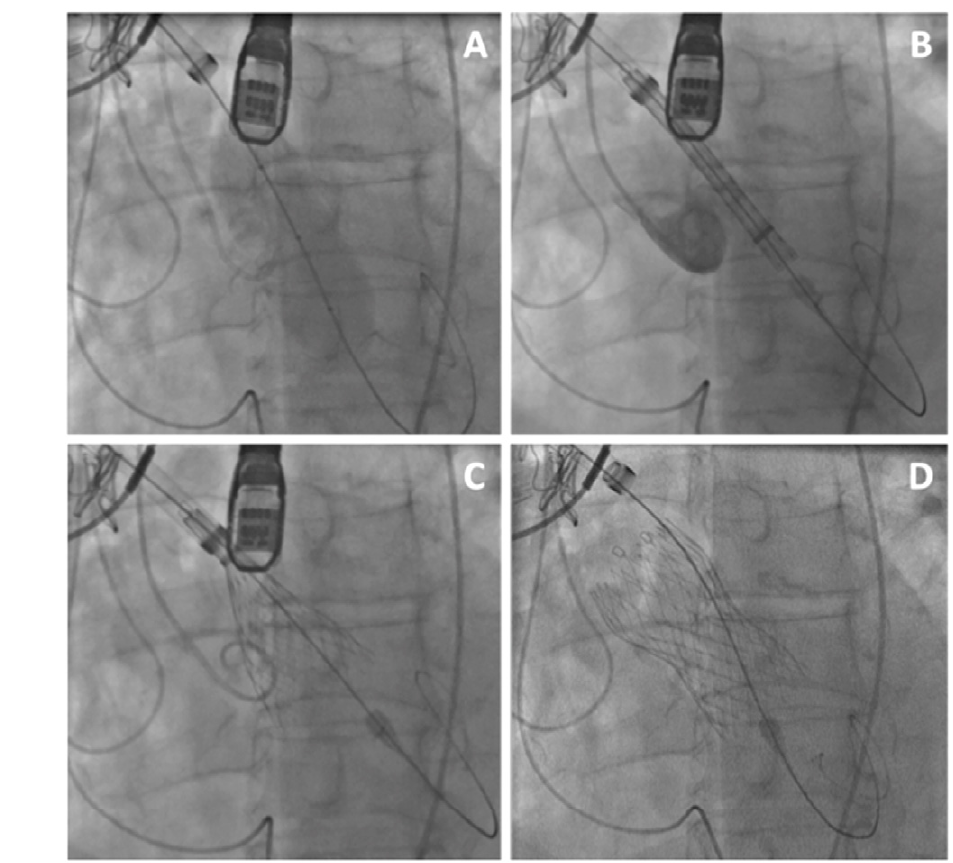
Figure 6. Fluoroscopic illustration of TAVI via direct aortic approach. A) Trans-aortic approach. Balloon aortic pre-dilatation under rapid right ventricular pacing. B) Self-expandable CoreValve R (cid:13) prosthesis aligned in pre- deployment position across aortic valve annulus into LVOT. Aortic injection demonstrates good position. C) CoreValve R (cid:13) two-thirds deployed. D) 18-Fr delivery sheath slightly withdrawn to facilitate full deployment of CoreValve R (cid:13)